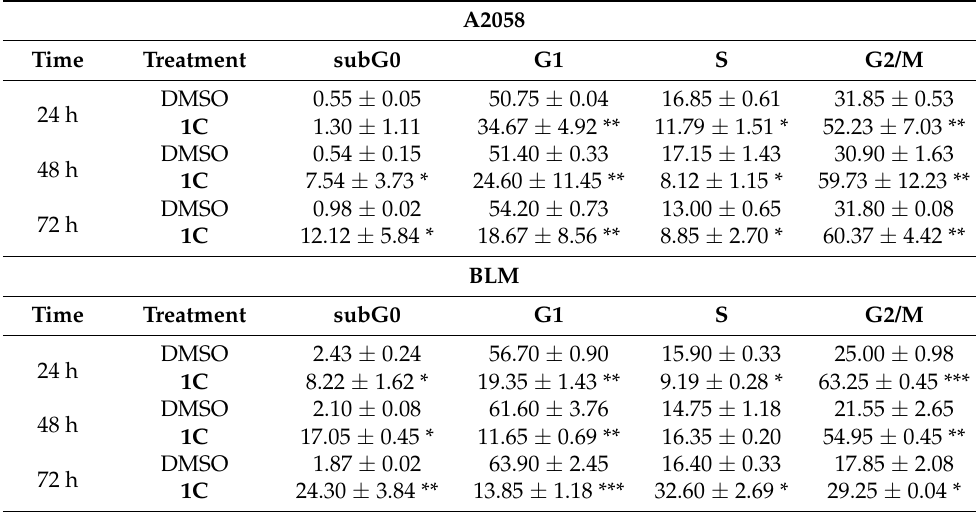
Table 3. Cell cycle analysis of A2058 and BLM melanoma cells after treatment with chalcone 1C for 24, 48 and 72 h at a concentration of 10 μ mol/L (A2058) and 20 μ mol/L (BLM).